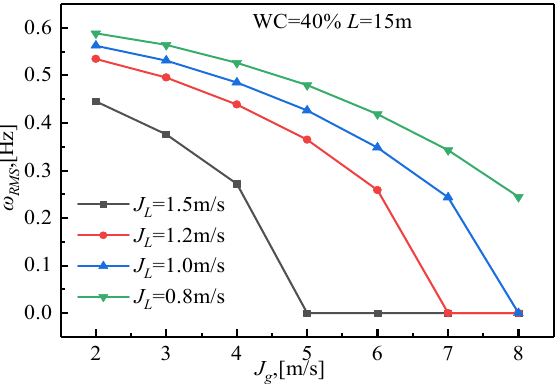
Figure 11. Variation of the critical gas velocity with WC: ( a ) Oil-based; ( b ) Water-based. In addition, the superficial liquid velocity has a great influence on the critical gas velocity. As can be seen from Figure 12, the critical gas velocity is absent in the whole range of superficial gas velocity for J L = 0.8 m/s. The critical gas velocities corresponding to J L = 1.0 m/s, J L = 1.2 m/s, and J L = 1.5 m/s are 8 m/s, 7 m/s, and 5 m/s, respectively. Evi- dently, the critical gas velocity tends to decline with the increase in superficial liquid velocity.